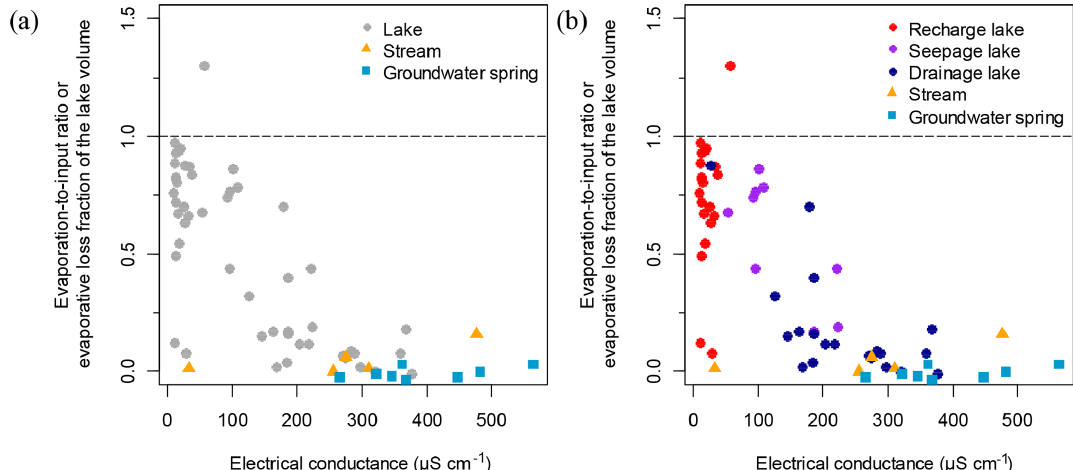
Figure 4. Relation between electrical conductance and calculated evaporation-to-inflow ratios. Lakes in panel (b) are coded according to a classification scheme developed in this paper.